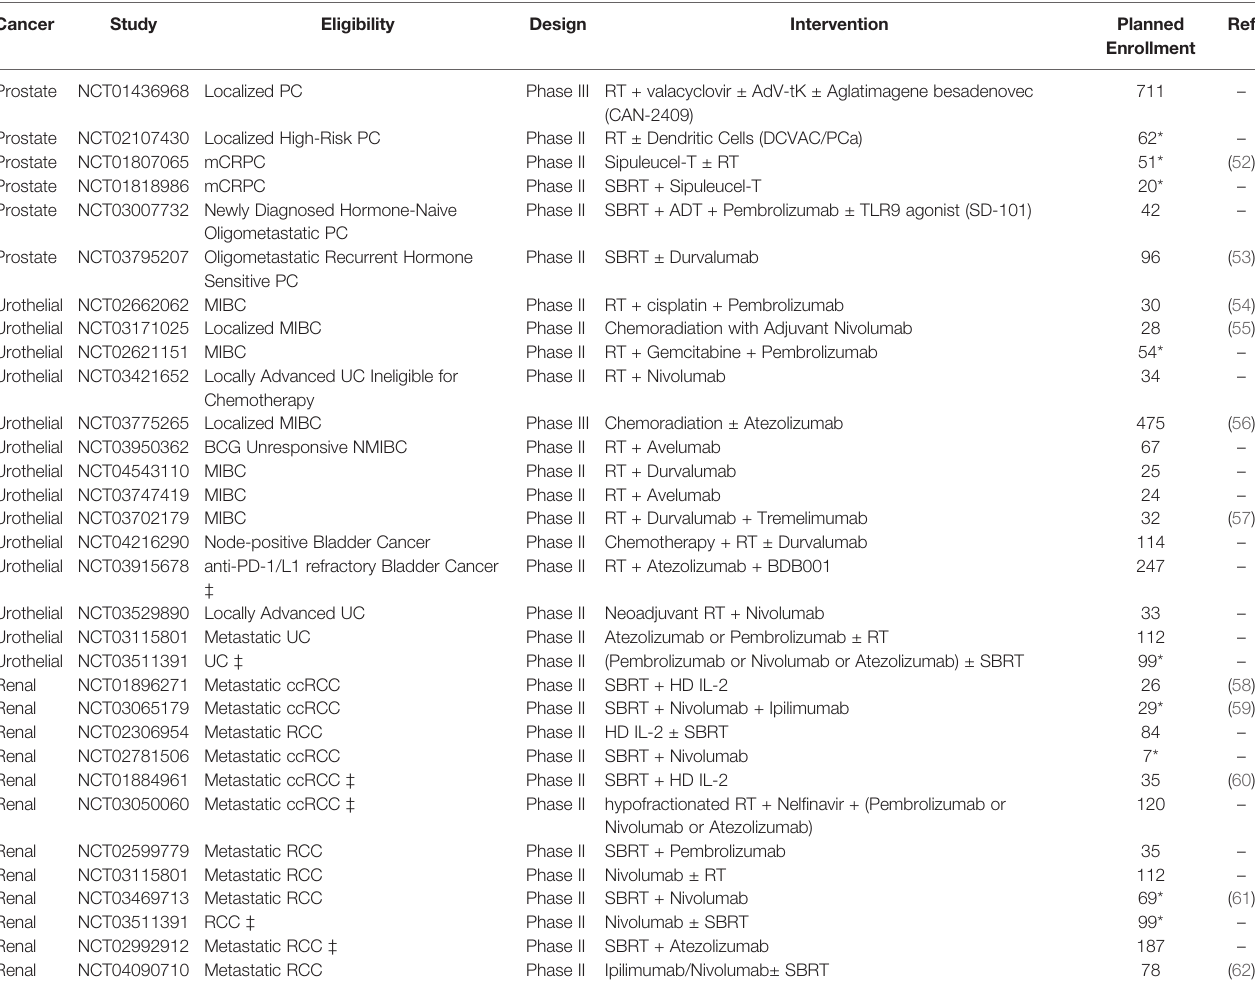
TABLE 1 | Active Phase II and III clinical trials combining immunotherapy with radiation therapy in genitourinary cancers.